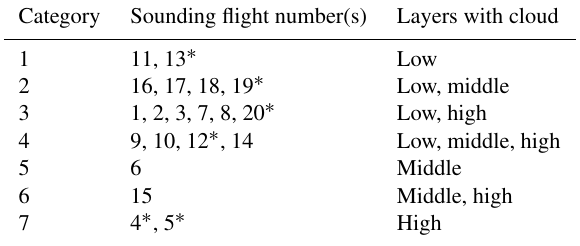
Table 8. Simple cloud classifications for radiosonde flight times. Based on hourly cloud frequency of occurrence at radiosonde launch time from the ARSCL data product. The “Layers with clouds” column is based on low < 3km, 3 < middle < 8km, high > 8km.